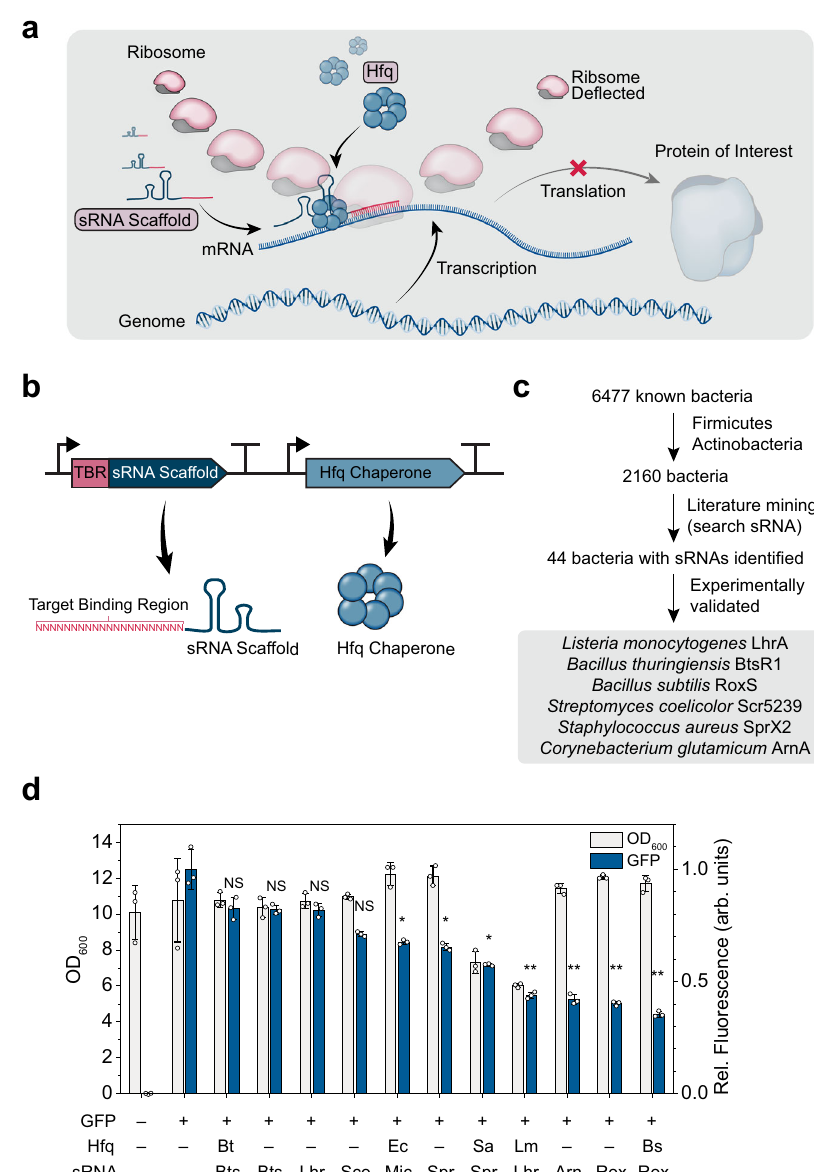
Fig. 1 | Development of synthetic sRNA systems for the knockdown of target genes. a Mechanism of synthetic sRNA-mediated translation repression. The sRNA scaffold and Hfq form a ribonucleoprotein complex and bind to a target binding region on the mRNA, resulting in the inhibition of protein translation by the ribo- some. b Components for synthetic sRNA-based gene knockdown. TBR, target binding region. c Procedure taken to select sRNA candidates derived from Gram- positive bacteria. d EffectsofvarioussyntheticsRNAscaffoldsand Hfqproteinson GFP fl uorescence knockdown ef fi ciency and cell growth of C. glutamicum .